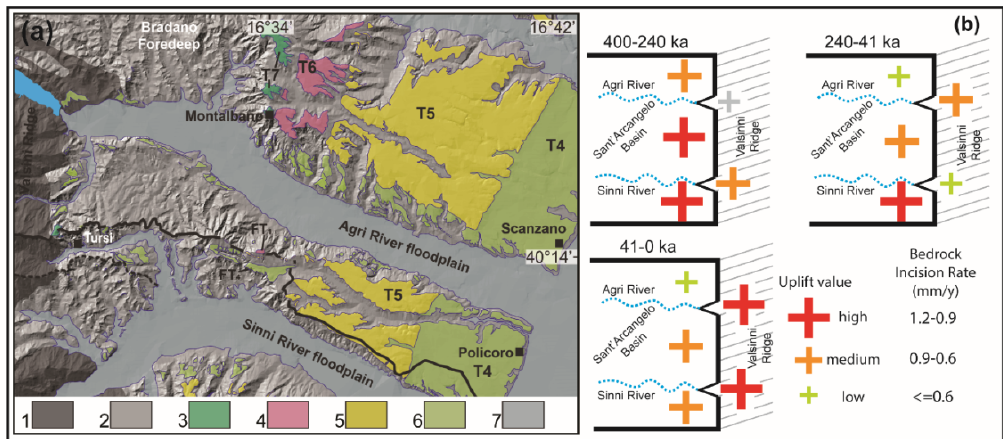
Figure 2. ( a ) Sketch map of marine terraces between Montalbano and Policoro villages (modified after [49]). Legend: 1. bedrock of the south Apennines chain; 2. Bradano Foredeep area; 3, 4, 5, 6. T7 to T4 orders of marine terraces, respectively; 7. Agri and Sinni rivers floodplains. ( b ) Differential tectonic uplift in the eastern sector of Sant’Arcangelo Basin and in the Valsinni Ridge during the last 400 ka (modified after [20]).